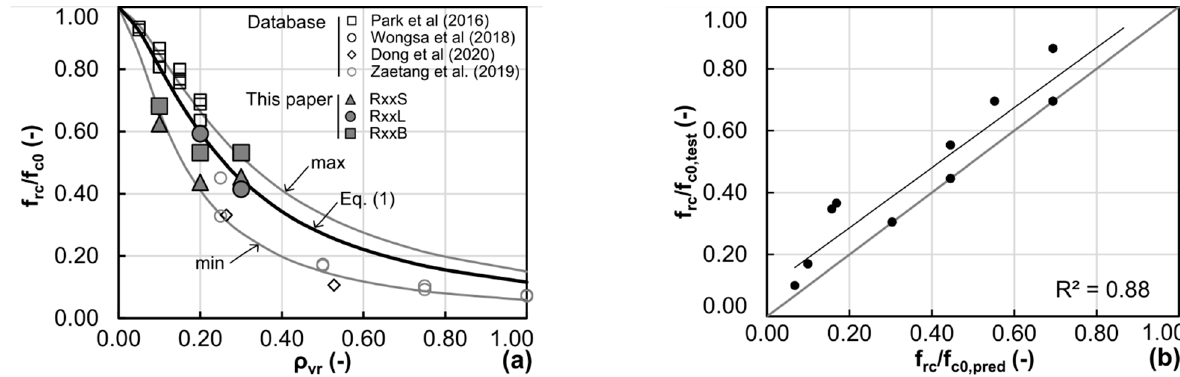
Figure 9. Compressive strength modelling: ( a ) relationship between strength ratio and rubber content, ( b ) function fitness.